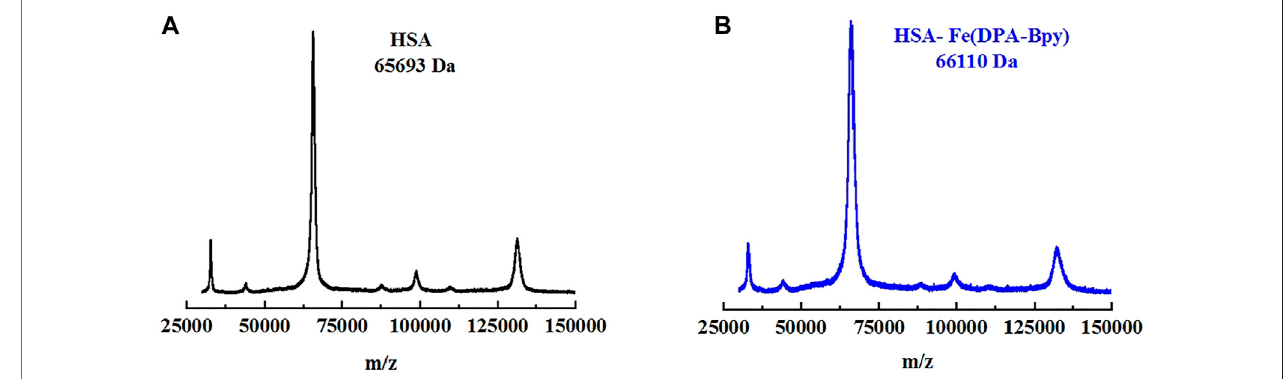
TABLE 3 | Crystallographic data collection and model re fi nement statistics for HSA Fe complex adduct. Parameters PDB code